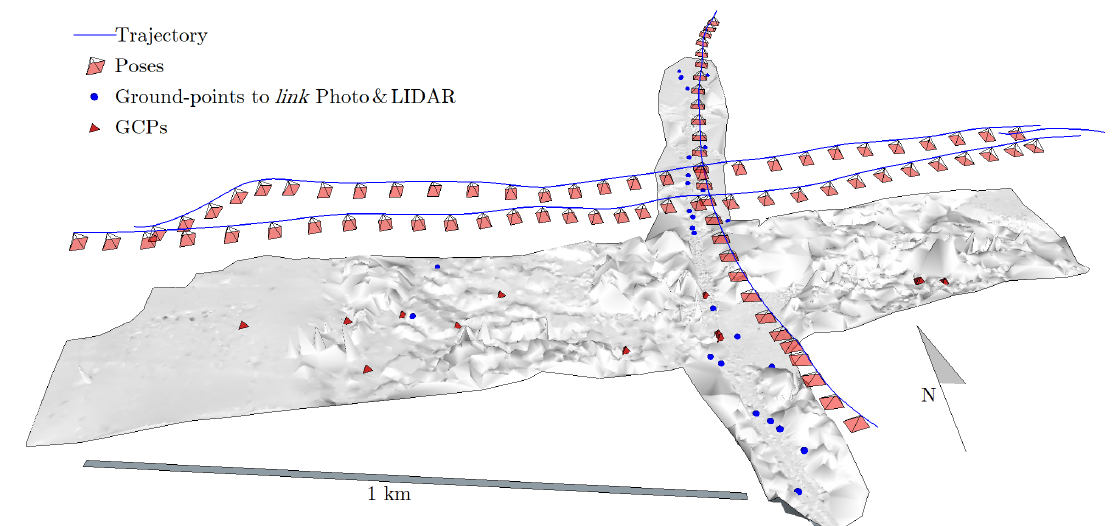
Figure 2. Test-site. Red triangles represent the GCPs, blue spheres represent links between Photogrammetry and LIDAR i.e. point on the ground measured both by LIDAR and on photos while switch-on bias variation is not specified. The noise √ hr . is estimated to be 0 . 3 ◦ /